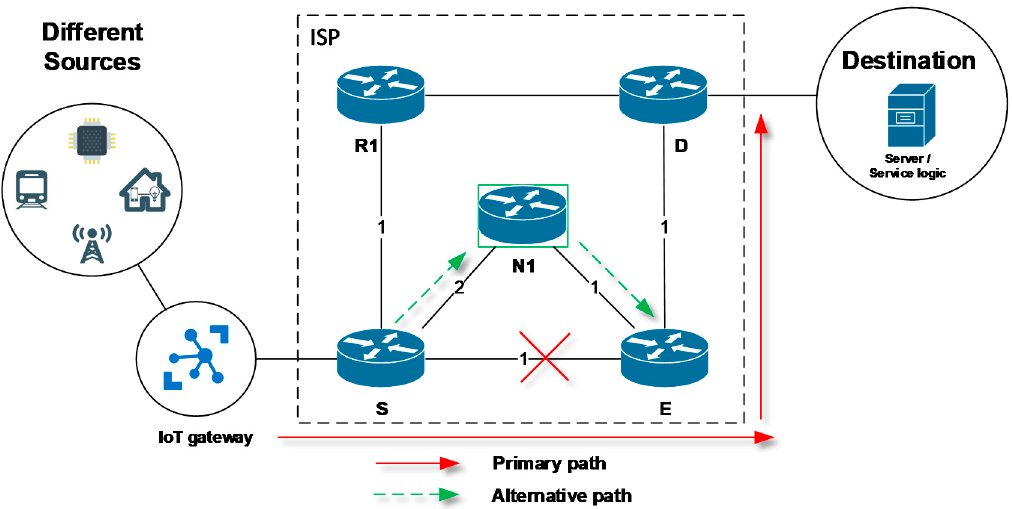
Figure 1. An example of the Fast ReRoute protection.